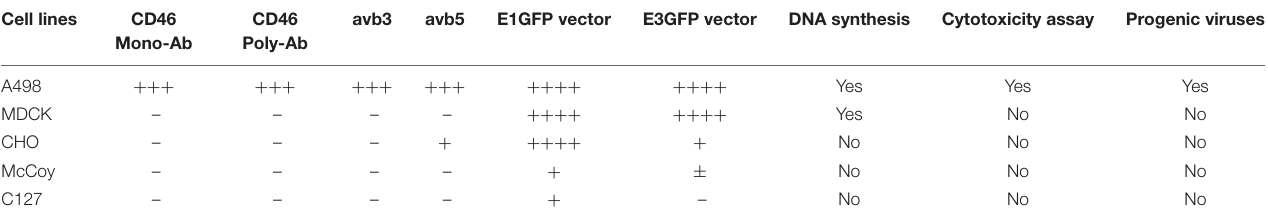
TABLE 1 | Characteristics of replication-competent adenovirus 11p E1/E3 GFP as expression vectors in dog, hamster, and mouse cells. Cell